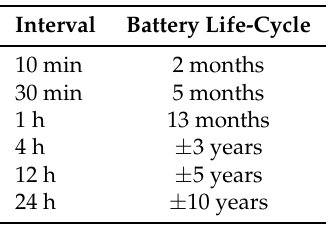
Table 2. Sensor node power consumption.